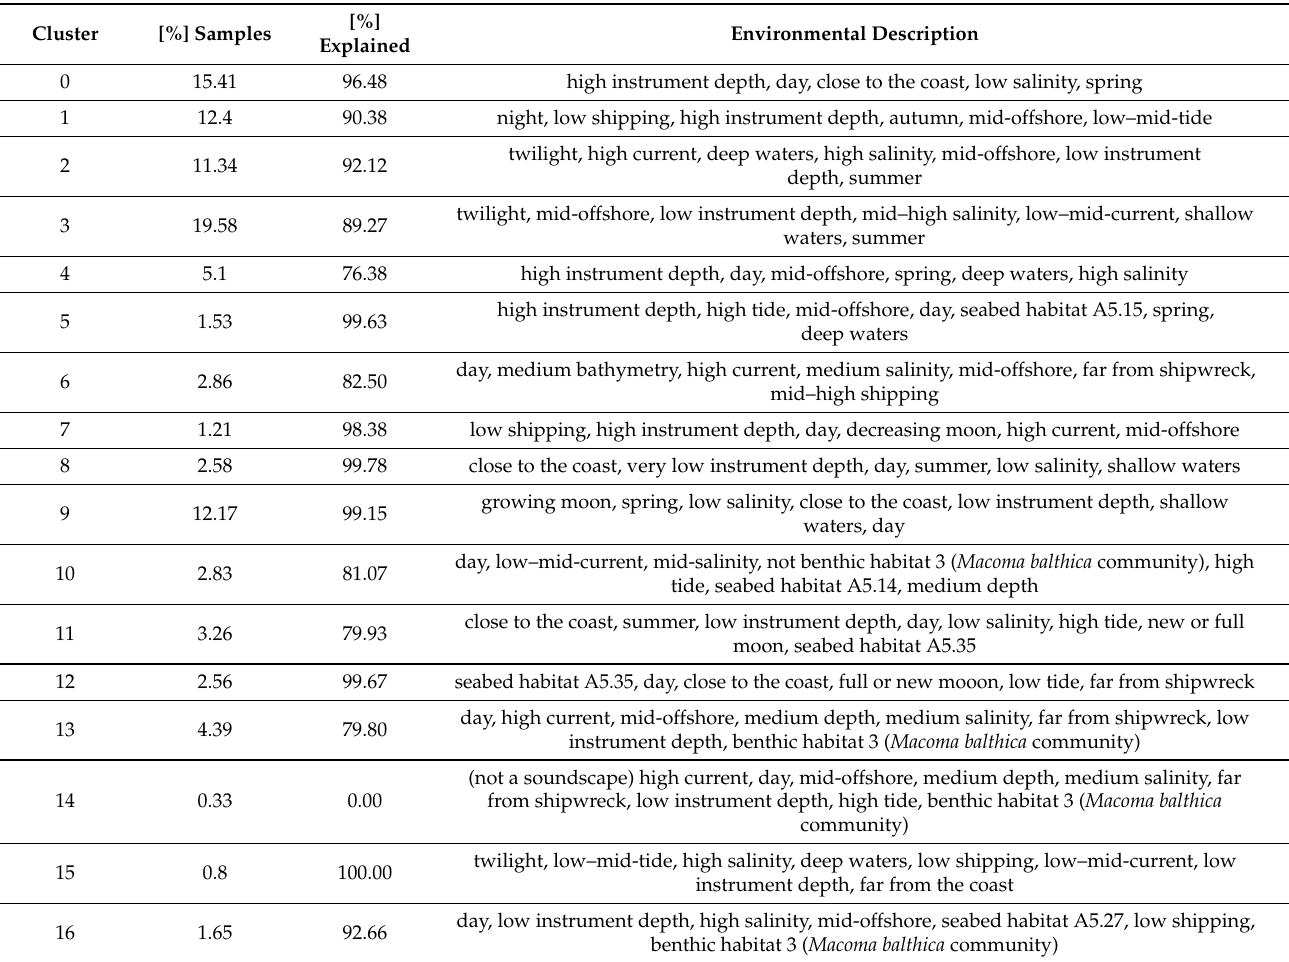
Table 3. Manual interpretation of the influence of the environmental variables in cluster differ- entiation. Because there was no sampling done in winter, medium values of week_n_cos were considered